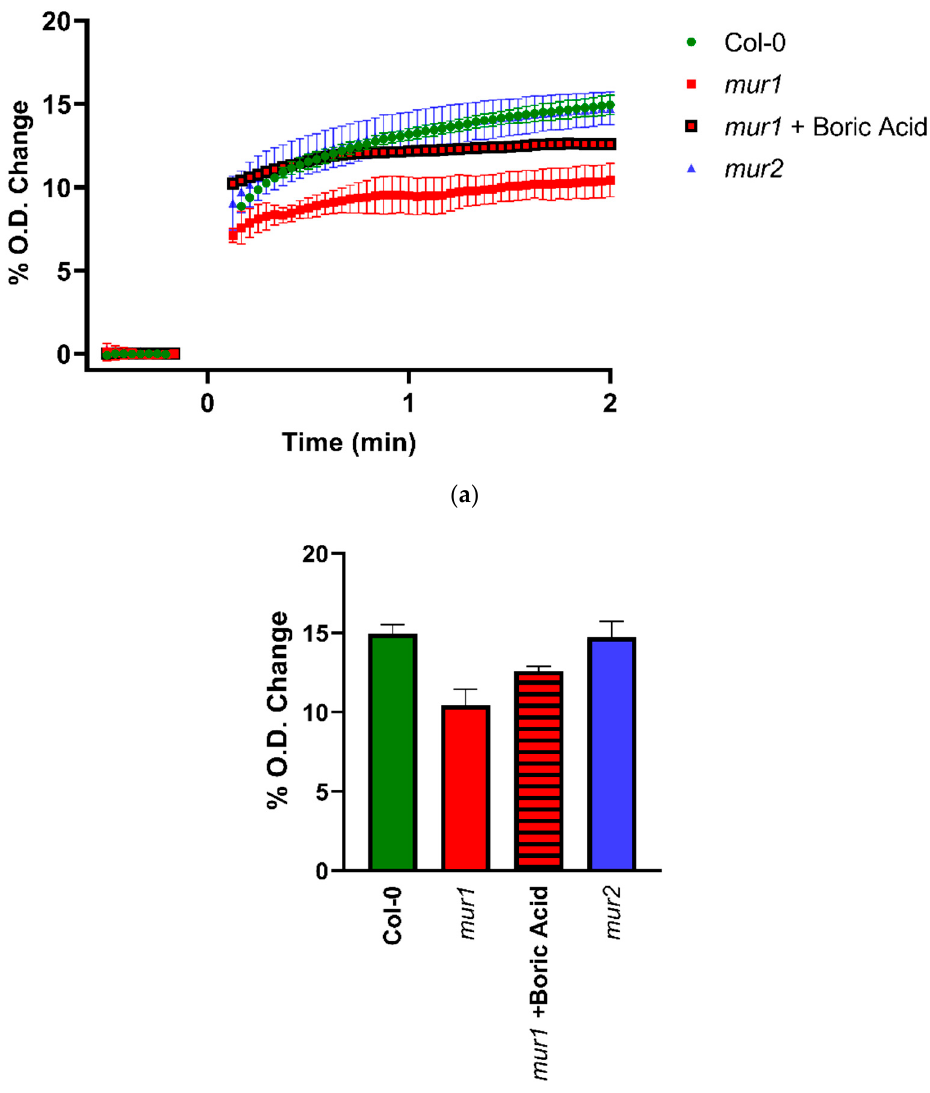
Figure 6. Effects of addition of 14 μ g CsExp1 expansin on swelling of cell wall fragments from Col-0, mur1, and mur2 Arabidopsis leaves and stems suspended in buffer, measured by its effect on proportional O.D. at λ = 750 nm relative to initial O.D. ( a ) Time course after addition of expansin at 0 s to Arabidopsis cell wall fragments from wild-type seedlings (green circles), mur1-2 seedlings (without boric acid pretreatment, red squares; with boric acid pretreatment, red squares with black border) and mur2 seedlings (blue triangles). ( b ) Summary of the O.D. increase 2 min after addition of expansin to Arabidopsis cell wall fragments from wild-type seedlings (green fill), mur1-2 seedlings (red fill), fragments from mur1-2 seedlings pretreated with boric acid (red fill with hatching), and fragments from mur2 (blue fill). Error bars indicate S.D. ( n = 3).